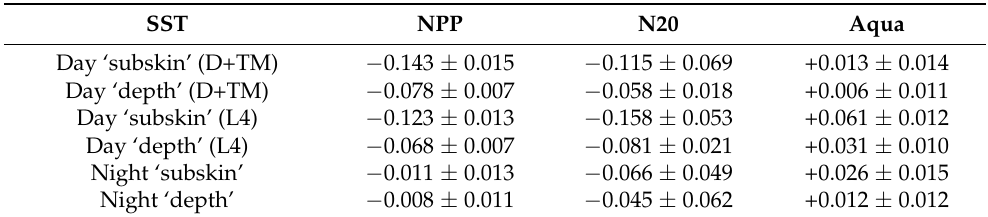
Table 4. Drift in ACSPO ∆ SSTs (K/decade) and associated uncertainties corresponding to a 95% confidence interval. Nighttime drifts are obtained via comparison to TMs presented in Figure 13a,b. The daytime results are calculated from day-night DDs of ACSPO—Reference ∆ SSTs, where Refer- ence = (D+TM) (Figure 14a,b) or L4 CMC SST (Figure